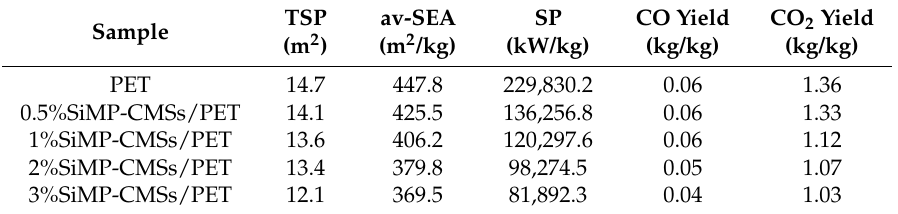
Table 3. Smoke parameters of the SiMP-CMSs/PET composites. SEA, specific extinction area; SP, smoke